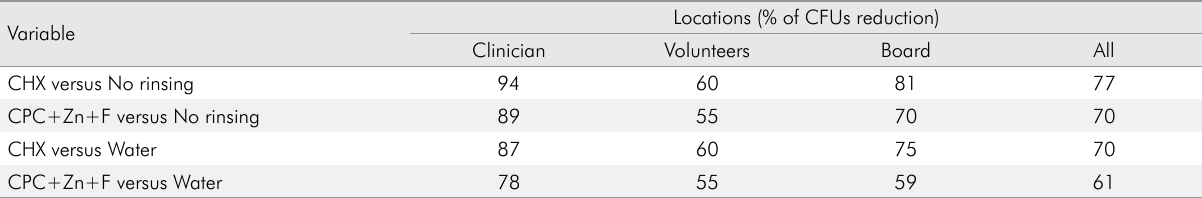
Table 2. Mean percentage of CFUs reduction (average values) in the CHX and CPC+Zn+F groups compared with the No Rinsing and Water groups considering all evaluated